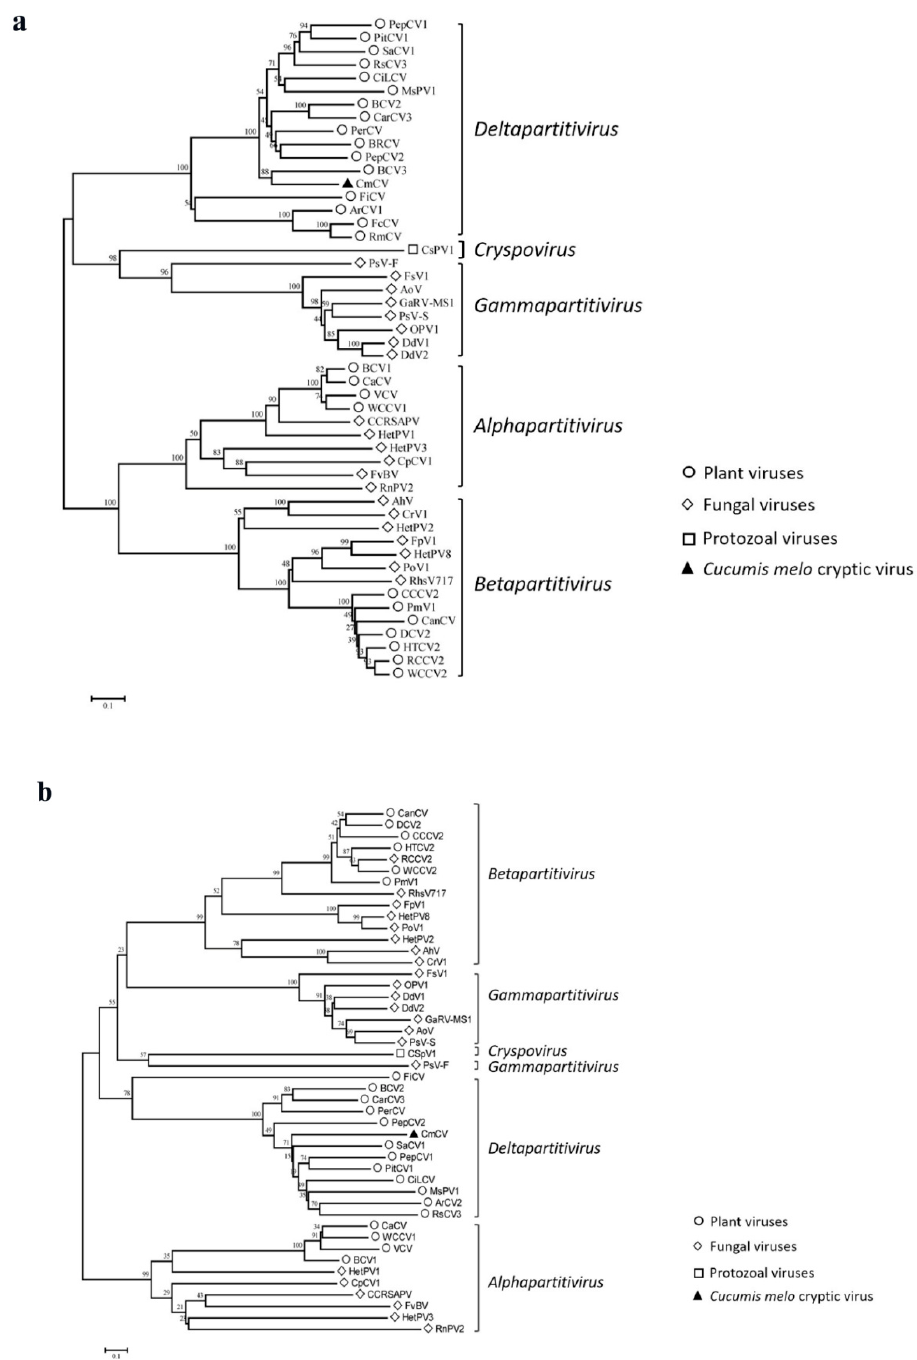
Figure 4. Phylogenetic relationships of CmCV and other members of the family Partitiviridae based on RdRp ( a ) and coat protein (CP) ( b ) amino acid sequences. The phylogenetic trees were constructed using the neighbor-joining method by MEGA 7.0 with a bootstrap of 1000 replicates. The symbols indicate the viruses isolated from the same group of host, such as plants, fungi, and protozoa.